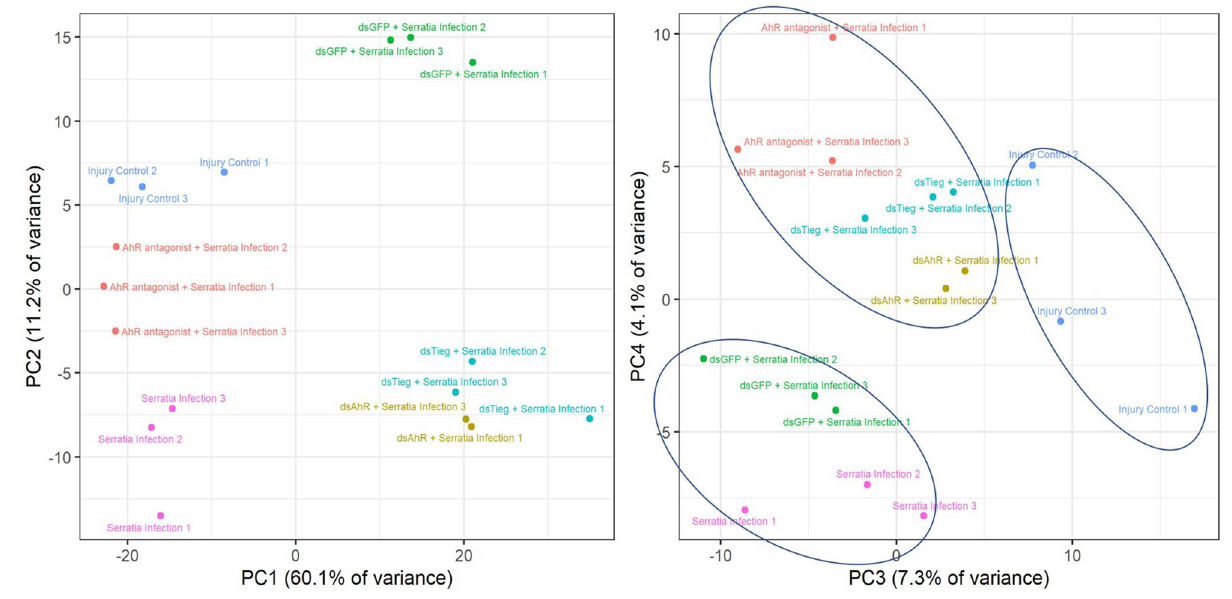
Figure 4. Principal component analysis (PCA) of transcriptomes. ( A ) The PC1 and PC2 explained the major variance of transcriptomes with different treatments. ( B ) The impact of AhR antagonist, dsAhR and dsKLF10 (dsTieg) on the transcriptomic response to the challenge was better represented by PC3 and